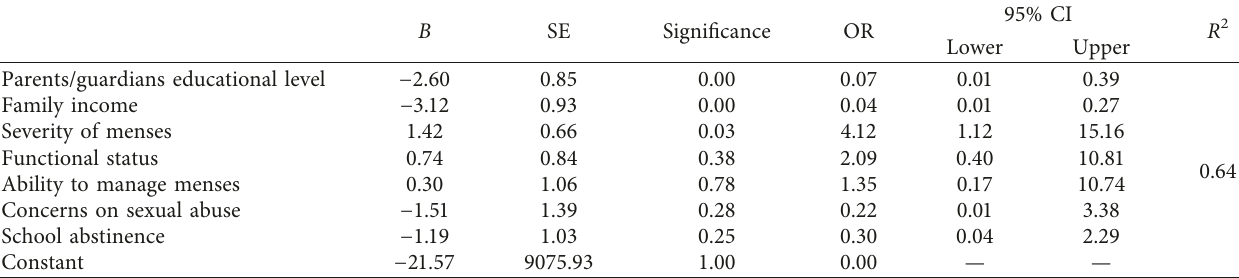
Table 2: Factors associated with awareness of parents/guardians on menstrual suppression in girls with intellectual disabilities.